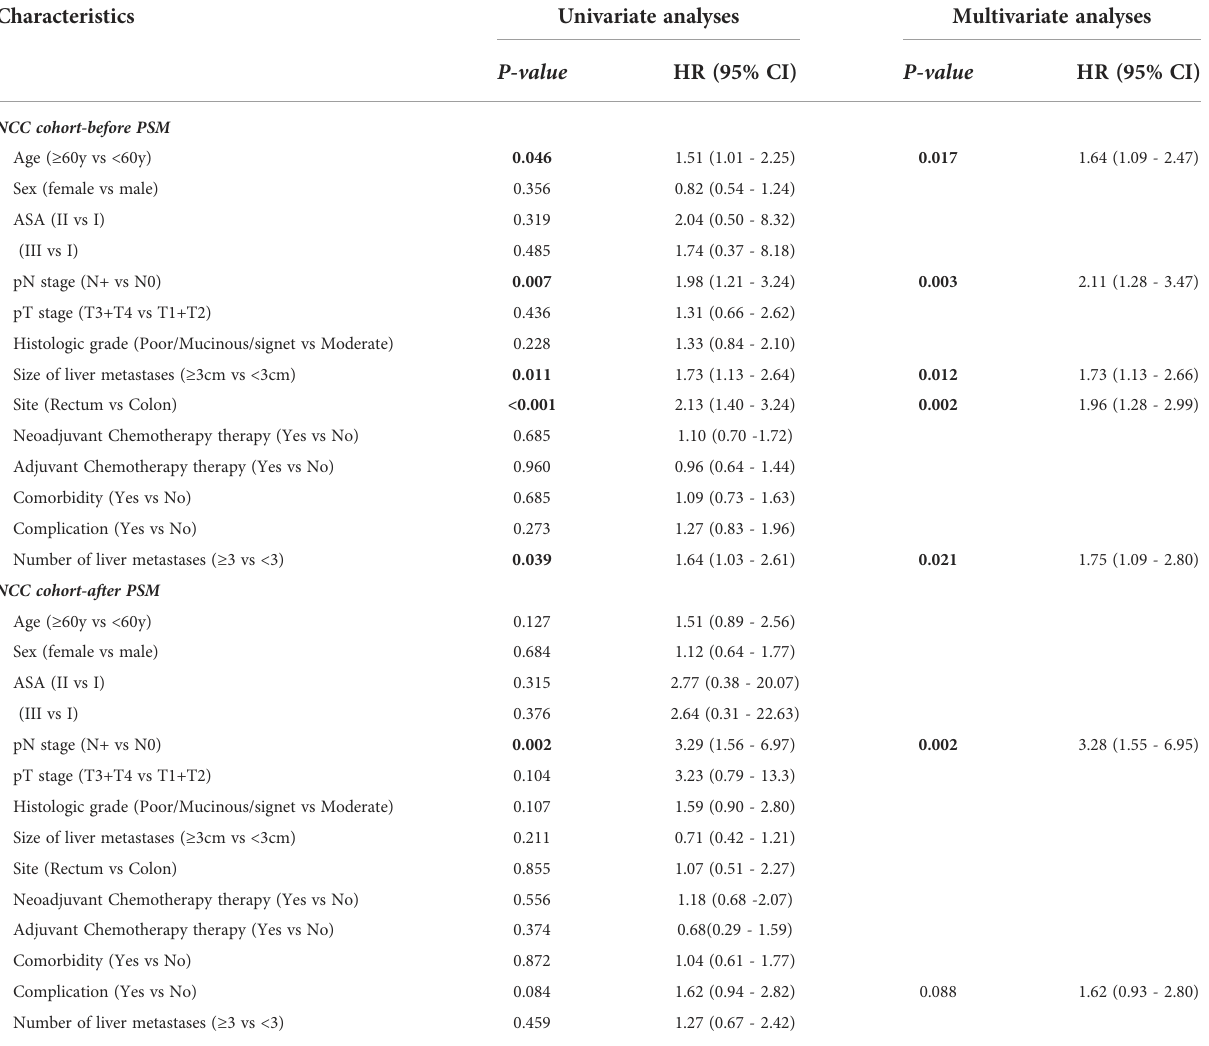
TABLE 4 Prognostic factors for OS in CRLM patients in the NCC cohort.